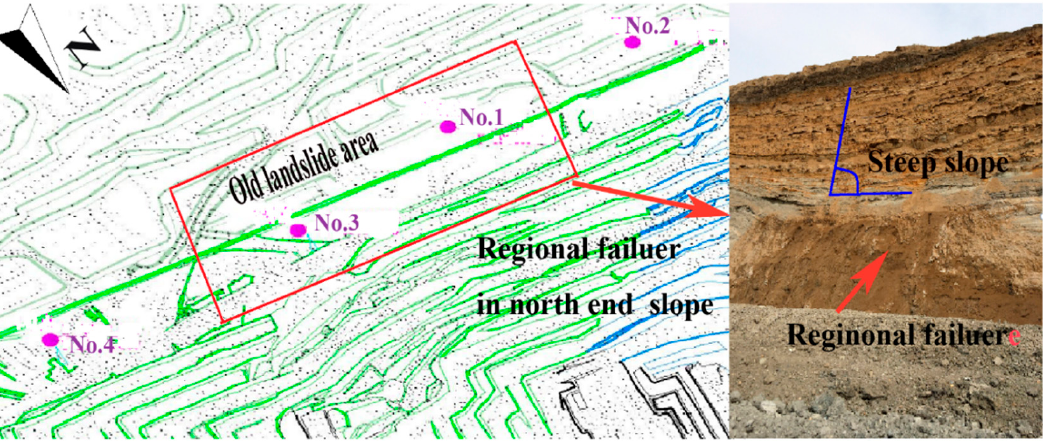
Figure 3. Field layout with 4 anchor monitoring points and regional landslide in north end slope.